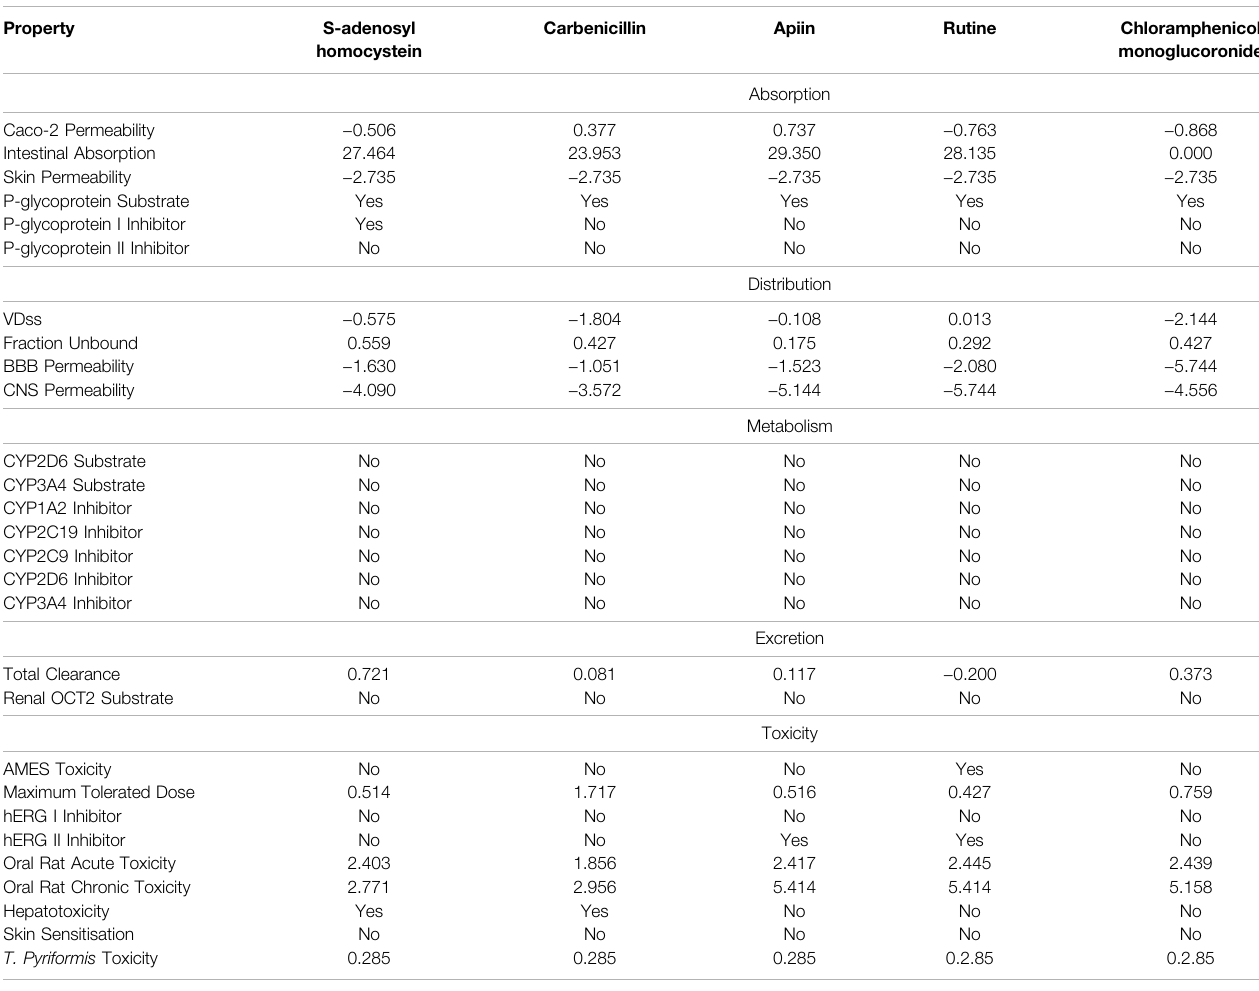
TABLE 3 | ADMET properties of the fi ve studied ligands.